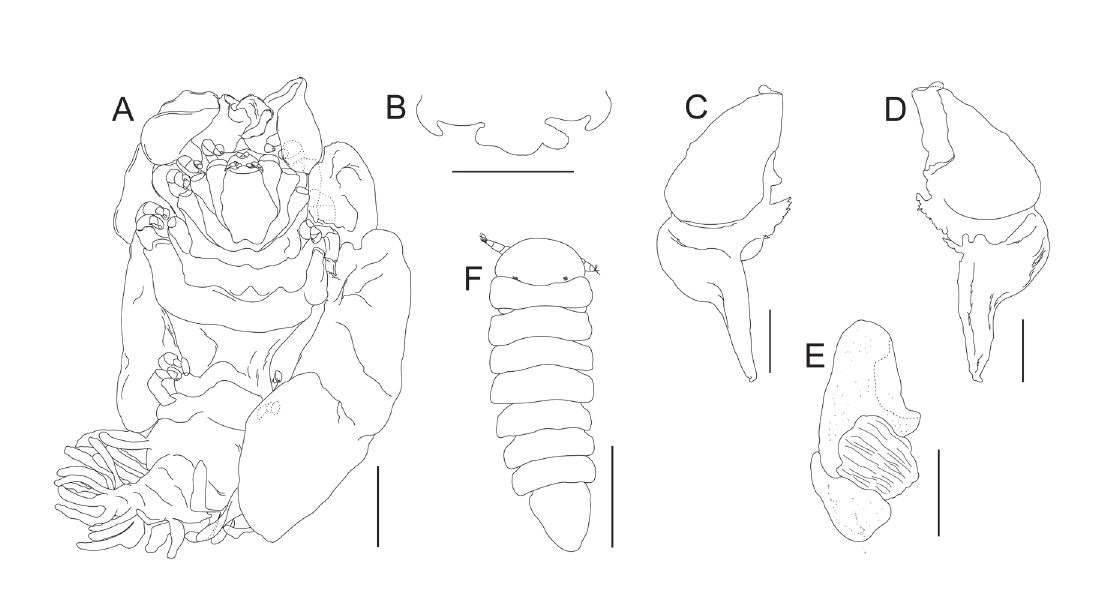
Fig. 3. Anathelges hyptius (Thompson, 1902). A . Ovigerous ♀, dorsal view (CNCR-36525-F). B . Barbula. C . First oostegite, external view. D . Same, internal view. E . Maxilliped. F . ♂, dorsal view (CNCR-36525-E). Scale bars: A = 1.0 mm; B–F = 0.5